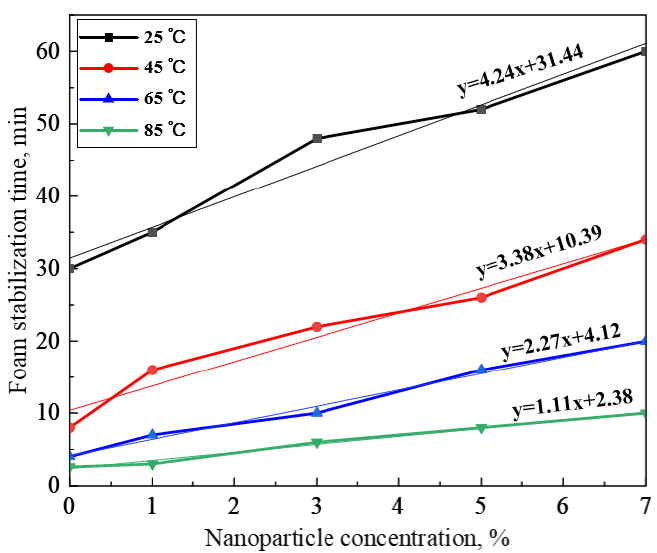
Figure 9. Foam stabilization time of dispersions at different temperatures.